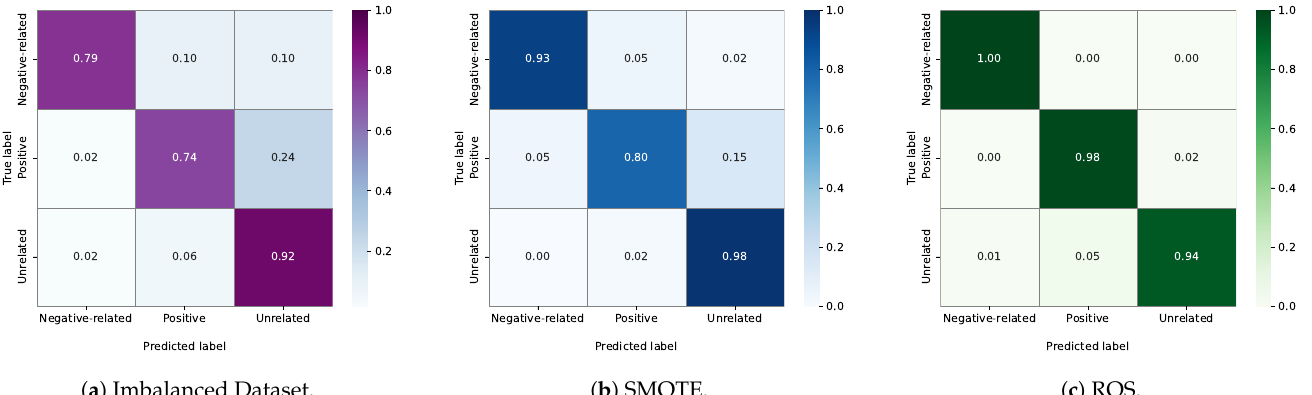
Figure 8. Confusion matrix of the proposed 1D-CNN-based model on imbalanced and oversam- pled